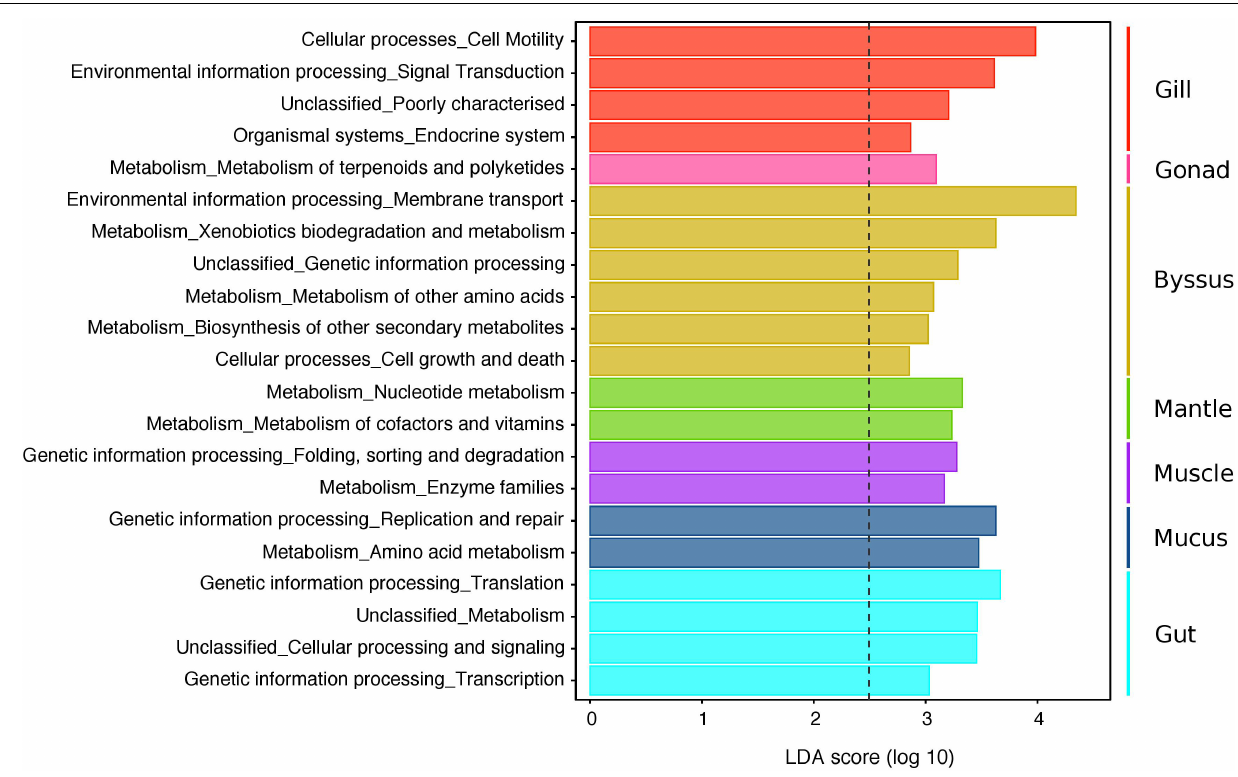
FIGURE 6 | LEfSe analysis displaying predicted functional profiles of the different tissue types in P. margaritifera . The barplot shows the 21 differentially abundant KEGG pathways (level 2) identified in the microbiomes of particular host tissues, based on a Linear Discriminant Analysis (LDA, p < 0.05 for factorial Kruskal–Wallis and pairwise Wilcoxon tests). Each colour denotes the tissue type, wherein the distinguishing functional traits were identified (Gill = red, Gonad = pink, Byssus gland = gold, Mantle = green, Muscle = purple, Mucus = blue, Gut = cyan). Only KEGG pathways meeting an LDA significant threshold > 2.5 are shown. The threshold of the logarithmic LDA score is represented by the dotted line. See Supplementary Data S6 for abundances of predicted gene counts of KEGG pathways (level 1 to